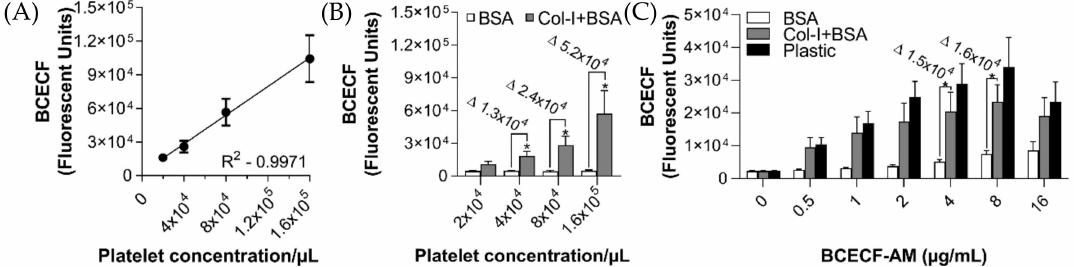
Figure 1. Platelet adhesion assay linearity in a 96-well plate. 96-well microplates were coated with collagen-I (8 µ g / mL in 50 µ L) or incubated with distillated water for 1 h at 37 ◦ C. After blocking the wells with BSA (0.03%), di ff erent concentrations of human washed platelets (2 × 10 4 to 1.6 × 10 5 / µ L in 100 µ L) were added, followed by incubation for 1 h at 37 ◦ C. Next, non-adherent platelets were removed, and adherent platelets were incubated with BCECF-AM (0.25 to 16 µ g / mL in 50 µ L) for 30 min at 37 ◦ C. Fluorescence intensity was measured using a plate reader (VictorX, PerkinElmer, Waltham, MA, USA). ( A ) Assay linearity (R 2 = 0.9971) was calculated by measuring the fluorescence signal of di ff erent platelet concentrations adhered to plastic. ( B ) The optimum platelet concentration to obtain statistical di ff erences between non-coated (white bars) and collagen-I-coated wells (grey bars) was assessed by using di ff erent platelet concentrations. ∆ represents delta: (Col-I + BSA) − (BSA). ( C ) The optimal concentration of BCECF-AM was assessed by comparing the fluorescence signal of adherent platelets (8 × 10 4 / µ L in 100 µ L) on non-coated wells (white bars) and collagen-I-coated wells (grey bars). Plastic was used as positive control (black bars). ∆ represents delta (Col-I + BSA) −